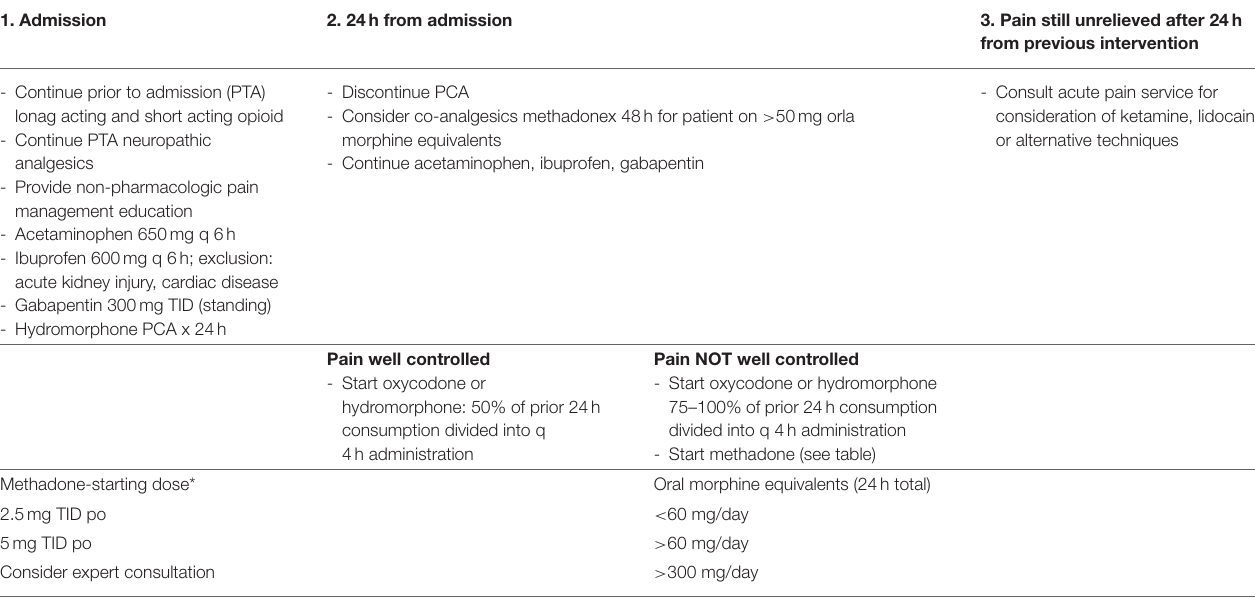
TABLE 1 | University of Chicago sickle cell disease vaso-occlusive inpatient pain management algorithm.